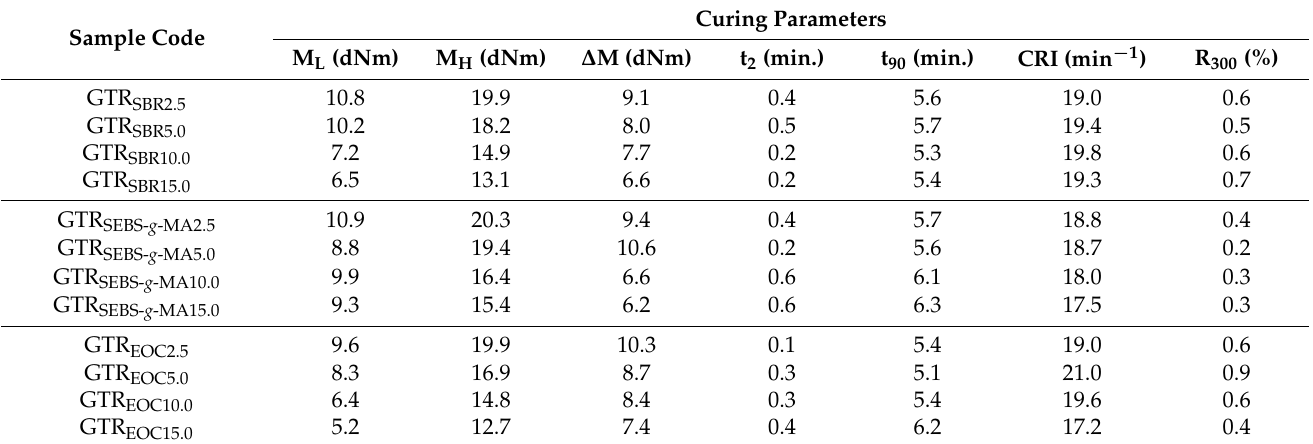
Table 3. Curing characteristics of modified GTR determined at 170 ◦ C.